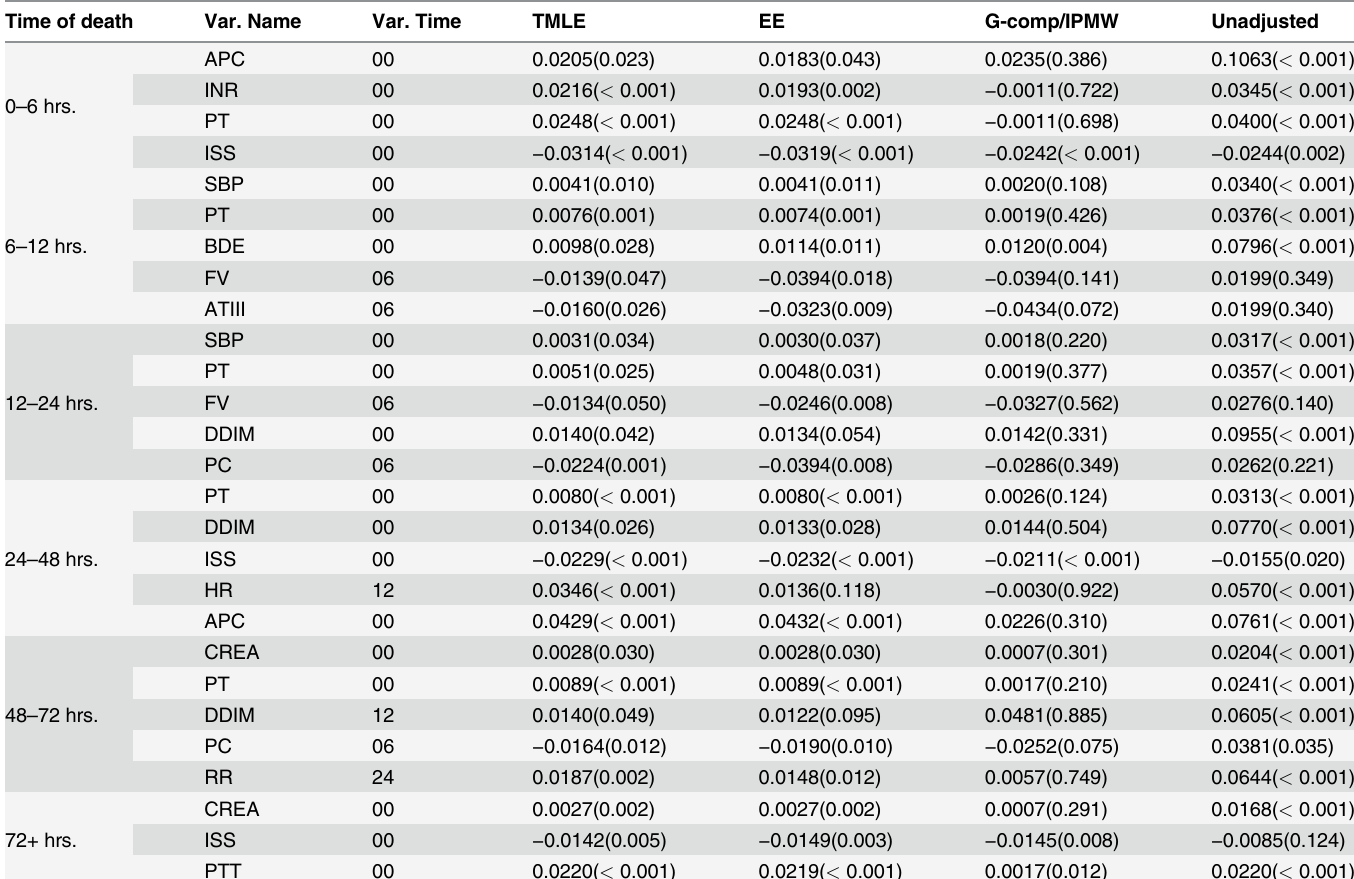
Table 2. VIM estimates for the most important variables for prediction of death at each time interval according to TML estimate (p-values in paren- theses and truncated at